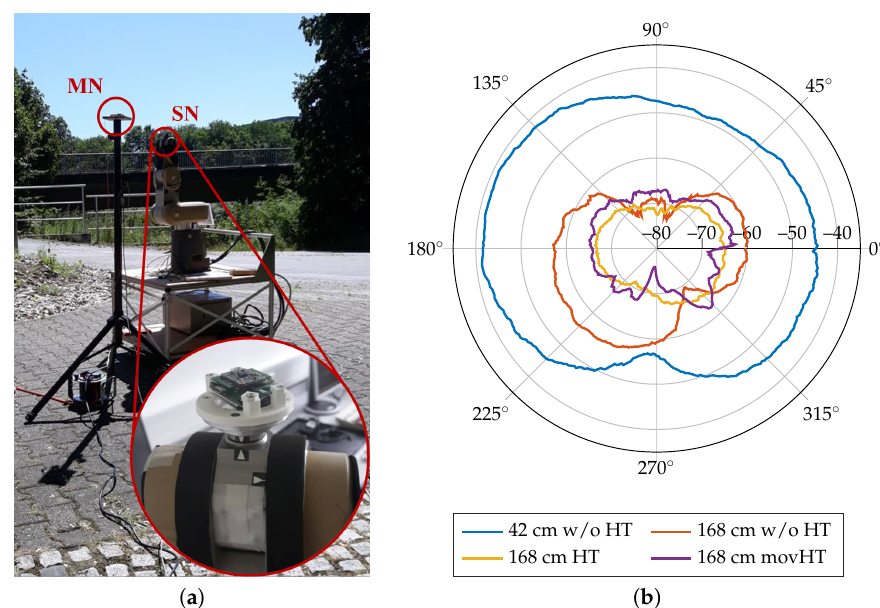
Figure 10. Receive Signal Strength Indicator (RSSI) measurements. ( a ) Measurement setup of the spatial RSSI recordings. The sensor node is placed at the end-effector of a turnable robot arm (red circled enlargement). The master node is statically placed at a fixed distance in front of the sensor node. ( b ) Receive Signal Strength over spatial angles for different distances (42 cm and 168 cm) and with additional interference of non-moving and moving human tissue (HT). Antenna (cf. PCB in Figure 1) is aligned with 180 ◦ . Table 3. Transmission performance during long-term measurements from unsupervised everyday office life activities. The calculation of RSSI and Packet Error Rate (PER) was performed for the entire data set (all) and gait phases only (gait) to specifically investigate the transmission behavior during gait.